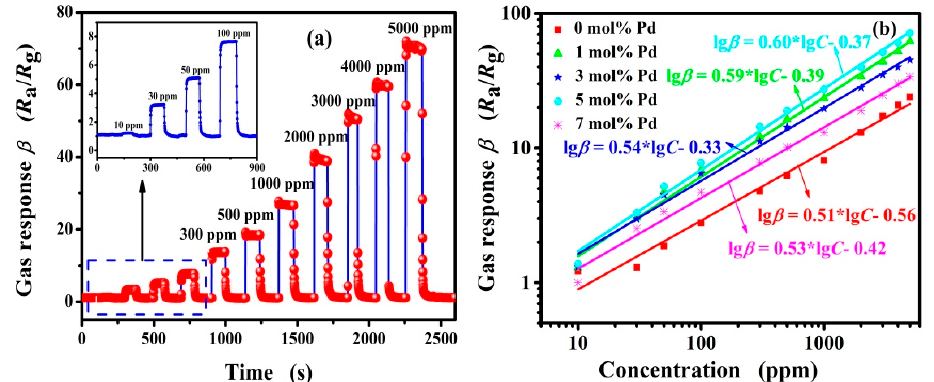
Figure 7. ( a ) The dynamic response/recovery curves of the sensor based on 5 mol % Pd-functionalized SnO 2 nanofibers to different butane concentrations from 10 to 5000 ppm at 260 °C; and ( b ) the variation of sensors based on (0, 1, 3, 5 and 7 mol %) Pd-functionalized SnO 2 nanofibers to butane with concentrations range from 10 to 5000 ppm at 260 °C.